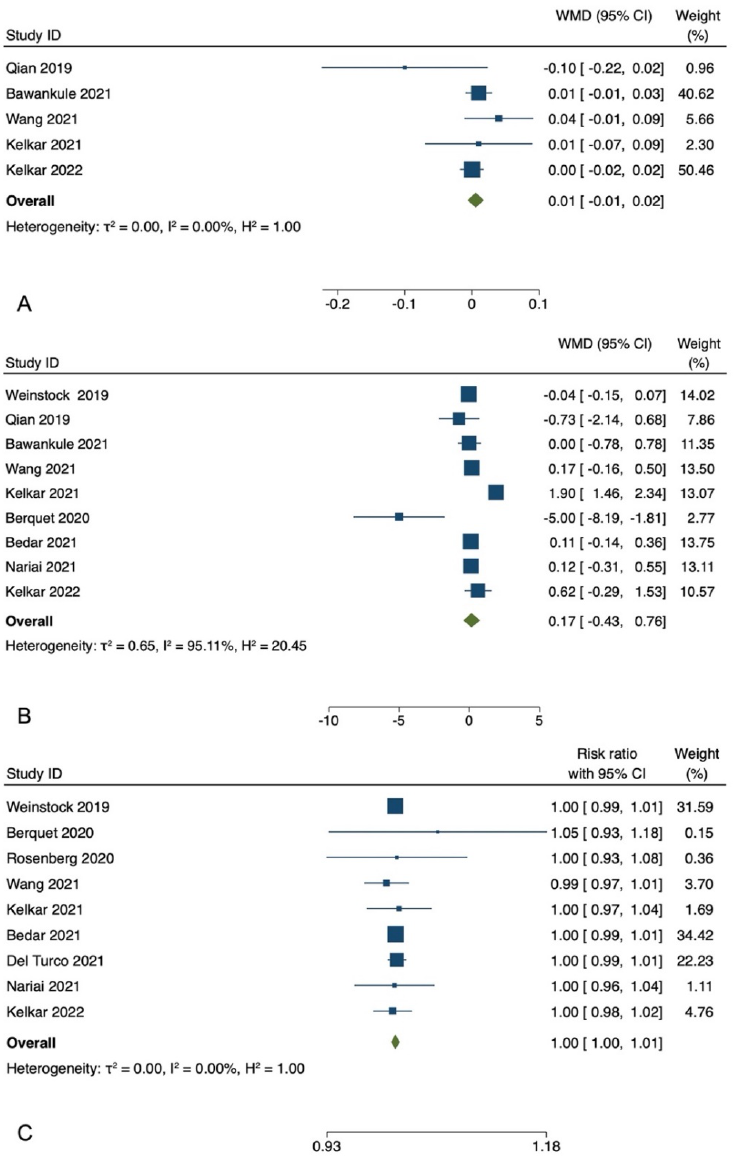
Figure 2. Meta-analyses of the comparison between the three-dimensional heads-up visualization system and the surgical operating microscope for postoperative best-corrected visual acuity ( A ) [5,7,9,13,14], mean surgical duration time ( B ) [4,5,7–9,11–14], and the incidence rate of intraopera- tive complications ( C )